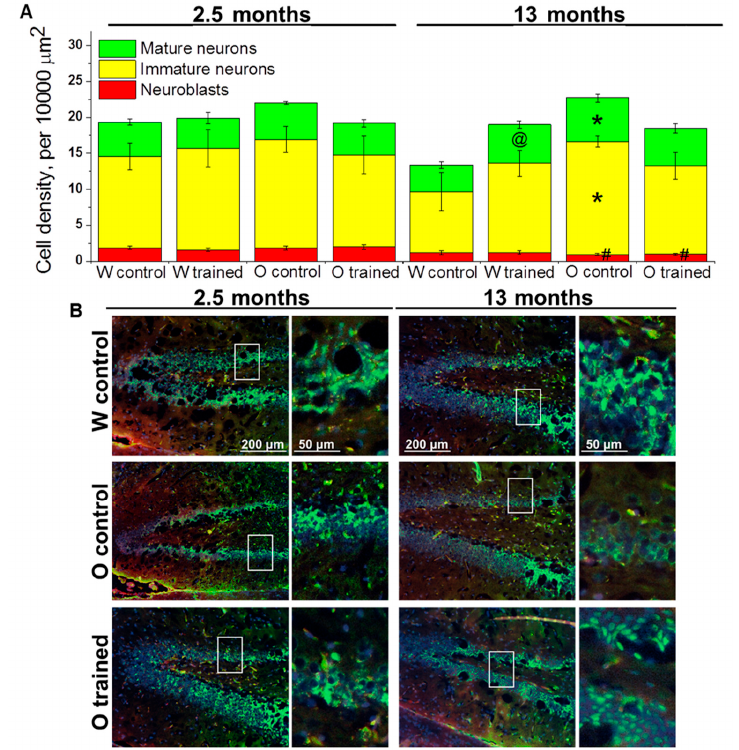
Figure 3. Density of cells of the neuronal lineage in the DG of OXYS and Wistar rats. ( A ) Genotype and MWM training did not influence the density of cells of the neuronal lineage at 2.5 months of age. At 13 months of age, the density of immature and mature neurons was higher in OXYS rats than in Wistar rats; training in MWM led to an increase of mature neurons’ density in Wistar rats. The data are presented as mean ± SEM, n = 3 to 6. * p < 0.05 for di ff erences between the strains; # p < 0.05 for a comparison with the previous age; @ p < 0.05 for e ff ects of the MWM training. W: Wistar rats; O: OXYS rats. ( B ) Photomicrographs of the DG of control Wistar and OXYS rats, as well as trained OXYS rats at ages 2.5 and 13 months are shown as representative images of immunohistochemical staining with antibodies against NeuN (green) and doublecortin (DCX; red). DAPI (blue) highlights cell